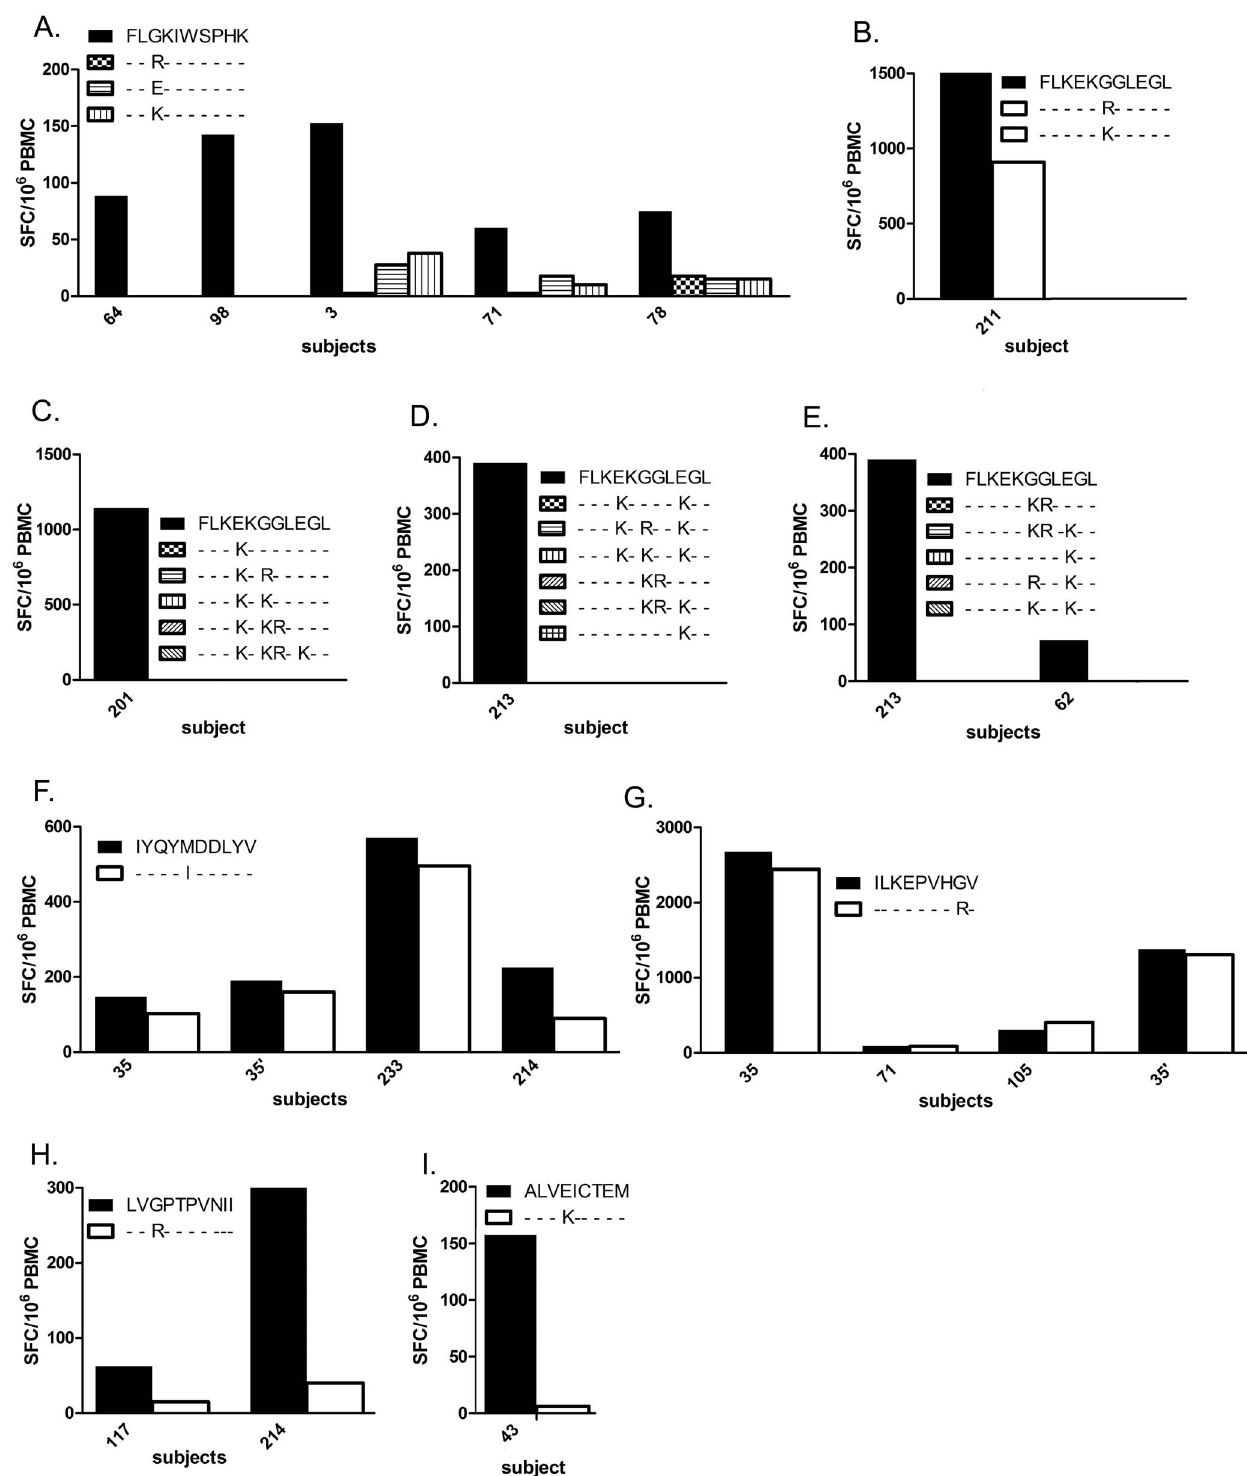
Figure 2. CD8 + T Cell response to HLA-A2-restricted wild type and A3G/F-mutated epitopes. Responses of PBMC from HLA-matched subjects to wild type and mutant epitopes are shown on the Y-axis, as IFN- c SFC/10 6 PBMC. A. Comparison of IFN- c induction between wild type and 3 mutant forms of the HLA-A2 restricted Gag epitope FLGKIWSPHK. B-E. Comparison of IFN- c induction between wild type and 15 mutant forms of the HLA-A2 restricted Nef epitope FLKEKGGLEGL. F. Comparison of IFN- c induction between wild type and a mutant form of the HLA-A2 restricted Pol epitope IYQYMDDLYV. G. Comparison of IFN- c induction between wild type and a mutant form of the HLA-A2 restricted Pol epitope ILKEPVHGV. H. Comparison of IFN- c induction between wild type and a mutant form of the HLA-A2 restricted Pol epitope LVGPTPVNII. I. Comparison of IFN- c induction between wild type and a mutant form of the HLA-A2 restricted Pol epitope ALVEICTEM.